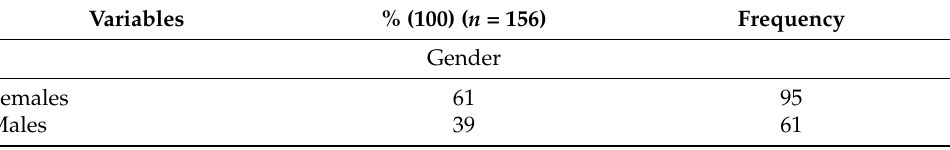
Table 1. Demographic characteristics of university students in the KwaZulu Natal province, South